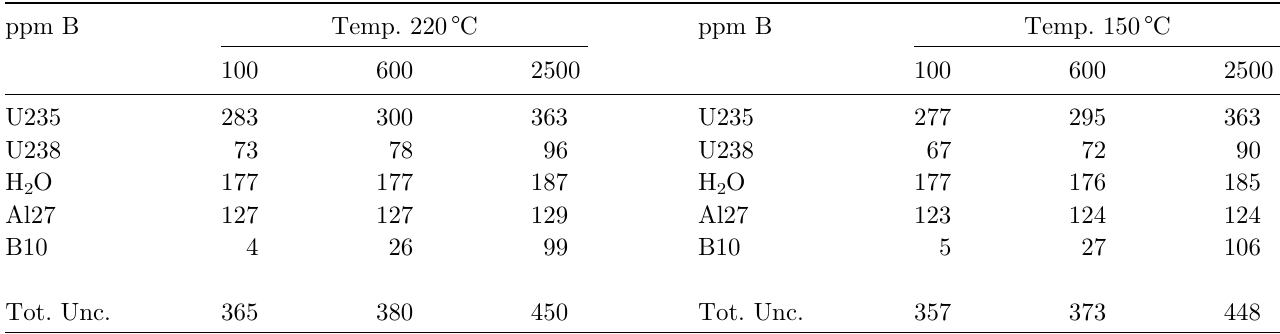
Table 3. Reactivity uncertainty for simultaneous variations of boron concentration and core temperature (pcm at 1 s ).